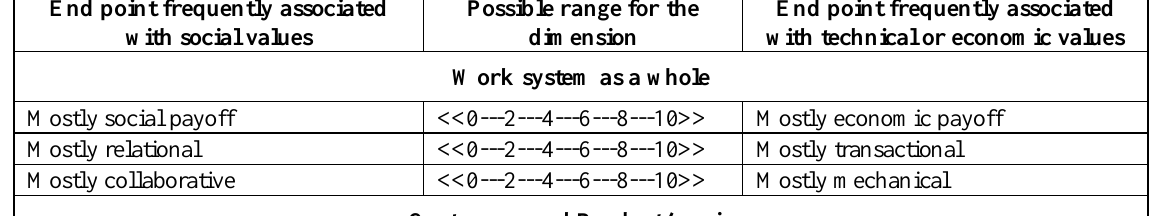
Table 4. Work system design dimensions that touch on values of the STS